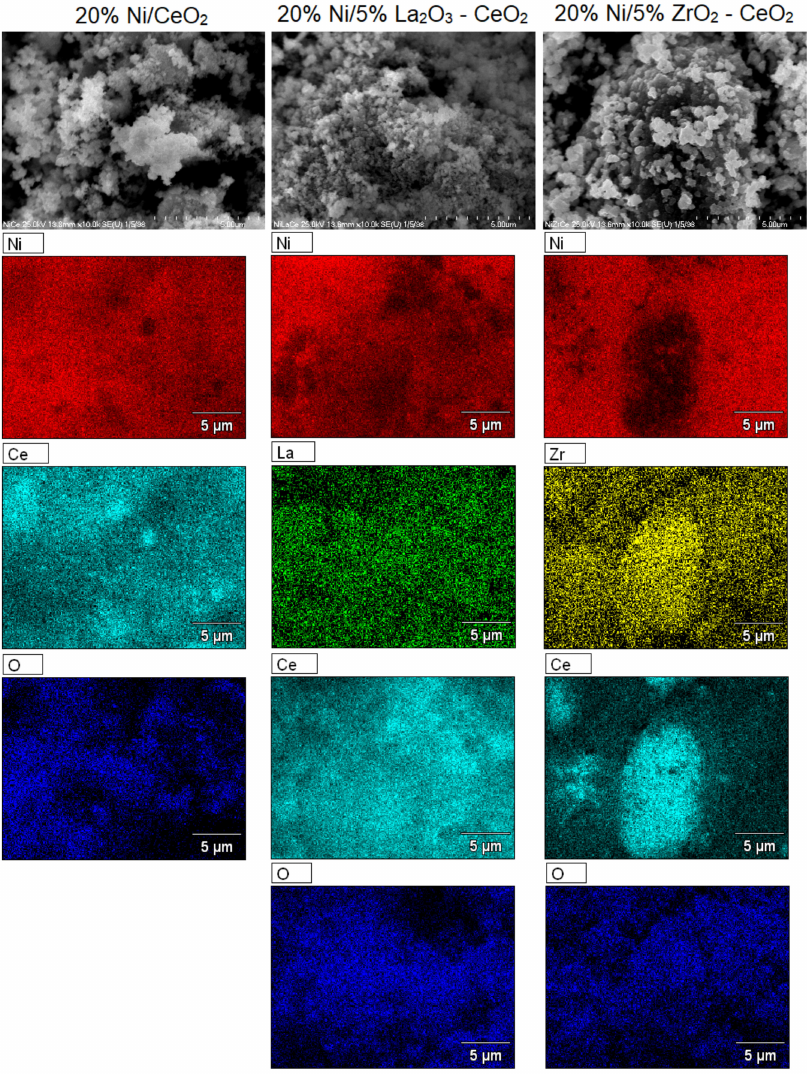
Figure 14. SEM images of 20% Ni/CeO 2 , 20% Ni/5% La 2 O 3 –CeO 2 and 20% Ni/5% ZrO 2 –CeO 2 catalysts calcined in air atmosphere at 400 ◦ C for 4